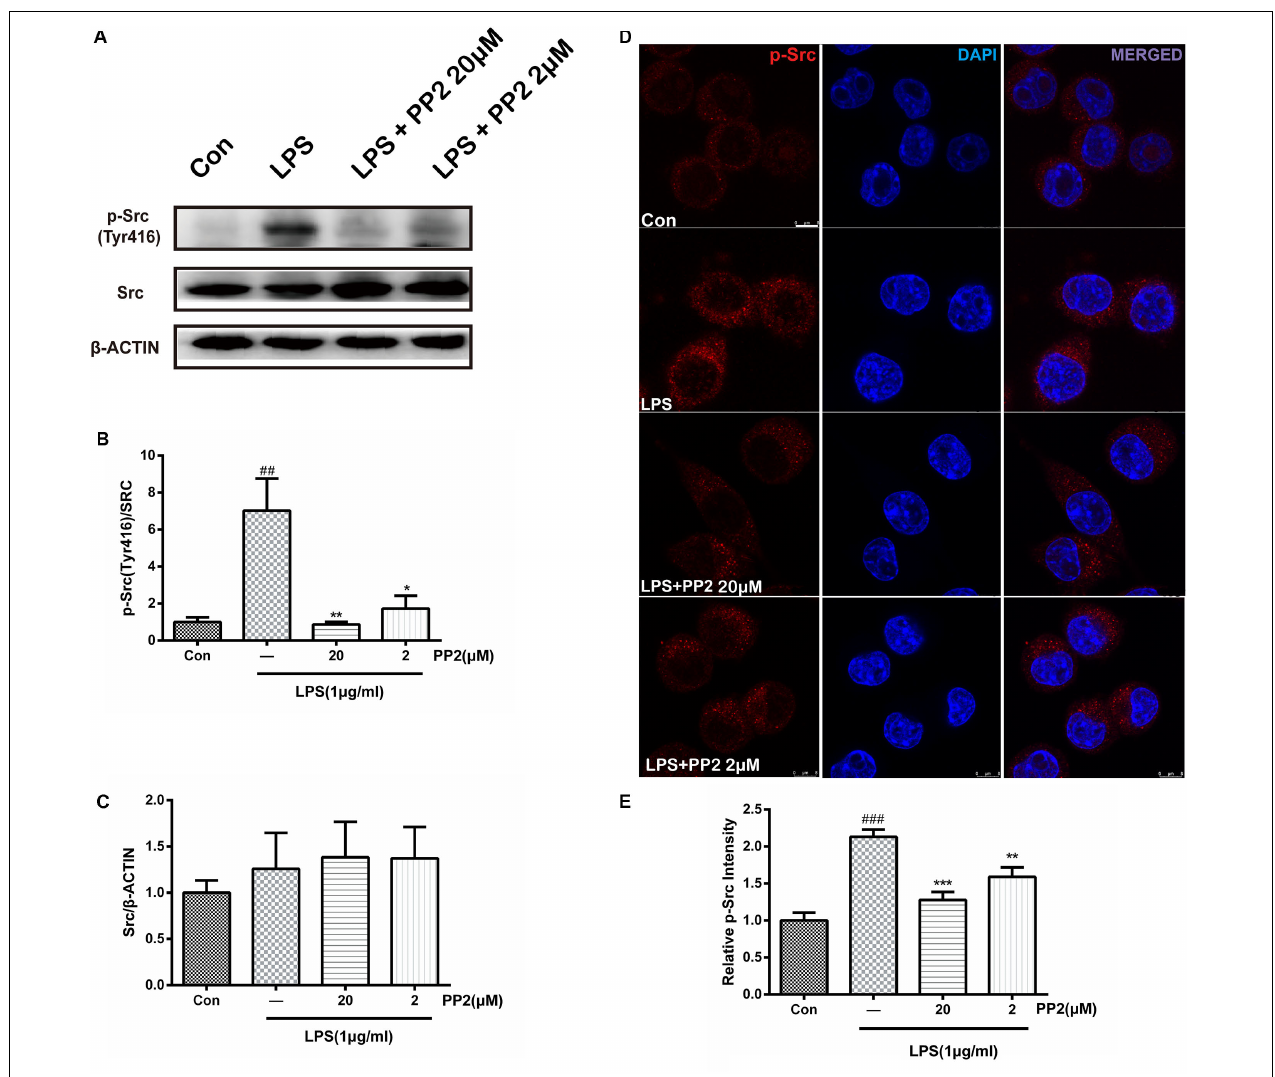
FIGURE 1 | The efficiency of Src inhibitor PP2 was confirmed in lipopolysaccharide (LPS)-induced BV2 activation. Cultured BV2 microglia were treated with two concentrations of PP2 (2 and 20 µ M) in the presence of LPS (1 µ g/ml) for 24 h. (A–C) The protein levels of p-Src and Src were determined by western blot analysis. β -Actin was used as an internal loading control. Each bar represents the mean ± SEM. n = 4. ## P < 0.01 vs. control group,** P < 0.01, and * P < 0.05 vs. LPS group. (D) The cells were stained with anti-p-Src antibody (red) and DAPI stain (scale bar: 8 µ m). (E) The fluorescence intensity of the p-Src staining of was provided in a histogram. Each bar represents the mean ± SEM. n = 3. ### P < 0.001 vs. control group, ** P < 0.01 vs. LPS